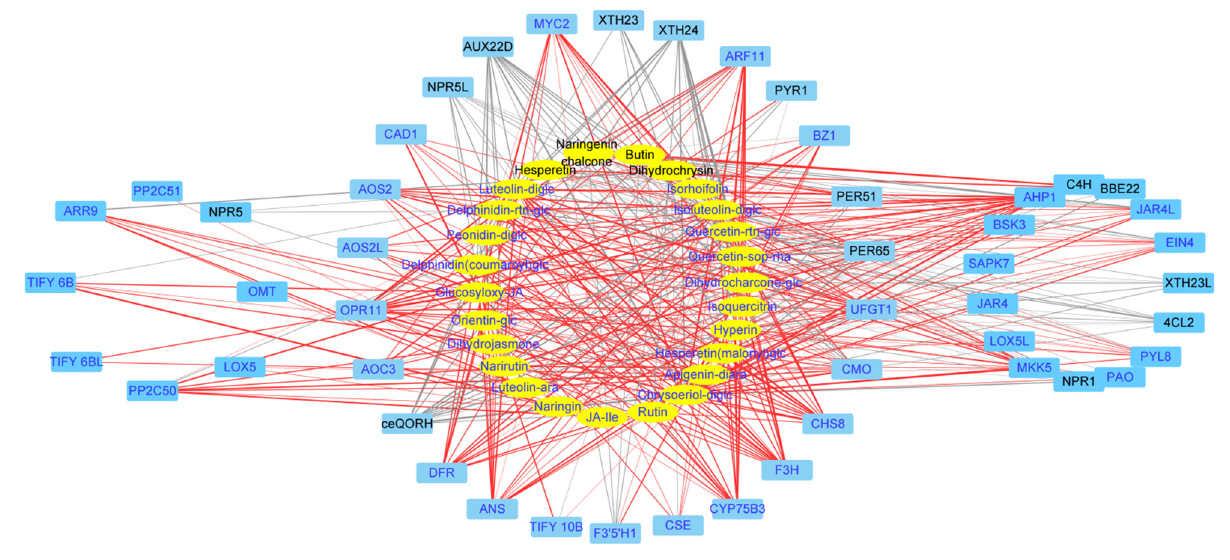
Figure 4. The network of DEGs in treatment-coupled modules and the altered flavonoids in light- or K-treated D. officinale. Metabolites are in the yellow ellipse and genes in the blue box. The upregulated DEGs or flavonoids were in blue font and those downregulated in black font. For the connection between genes and metabolites, the red lines indicated a positive correlation while the gray lines indicated a negative correlation. The treatment-altered pattern and annotation of metabolites or genes were given in Table S3.